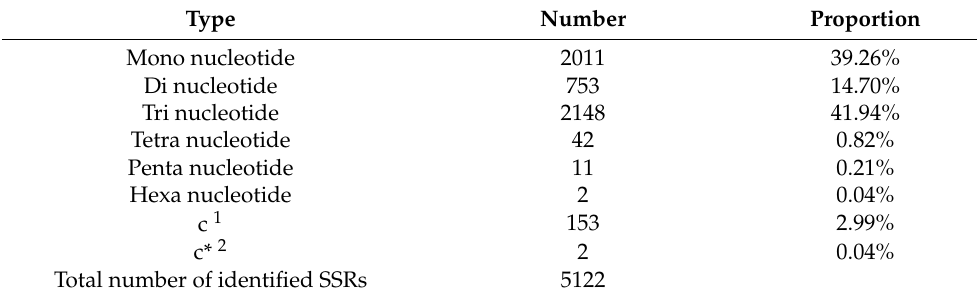
Table 3. The distribution and quantity of different SSR types.